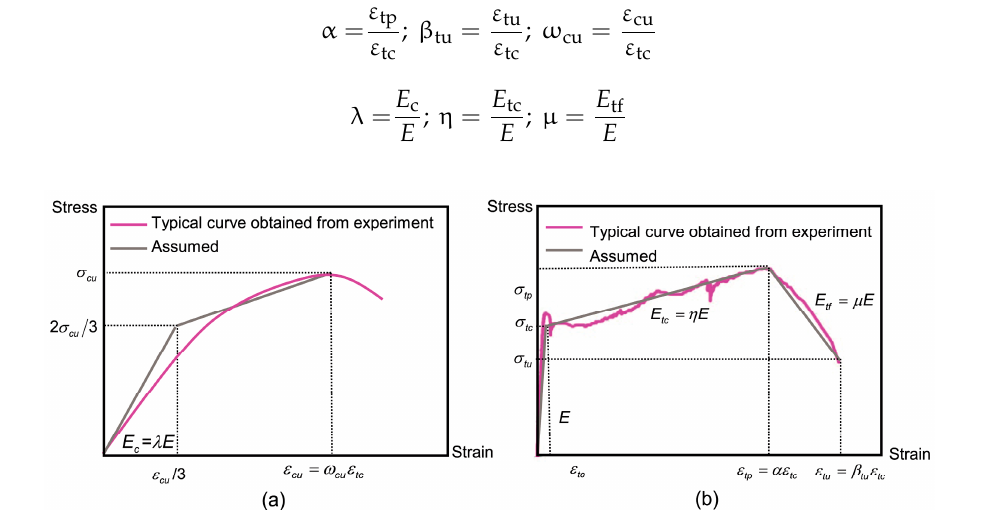
Figure 3. The proposed model of the SHCC in uniaxial tests, ( a ) stress-strain behavior of SHCC in uniaxial compression; ( b ) stress-strain behavior of SHCC in uniaxial compression.